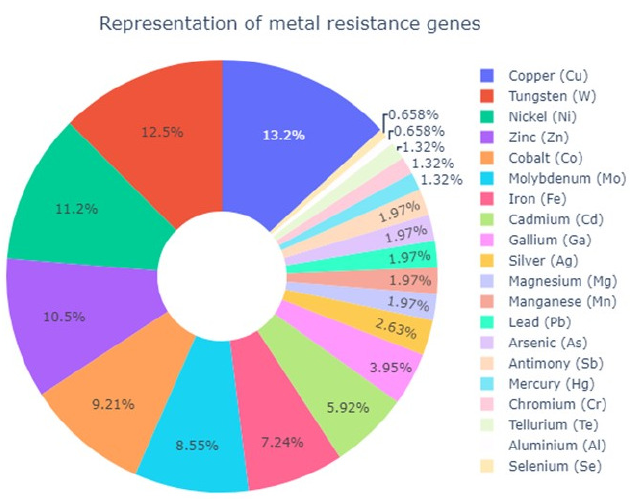
Figure 3. The number of genes associated with metal resistance in S. xiamenensis